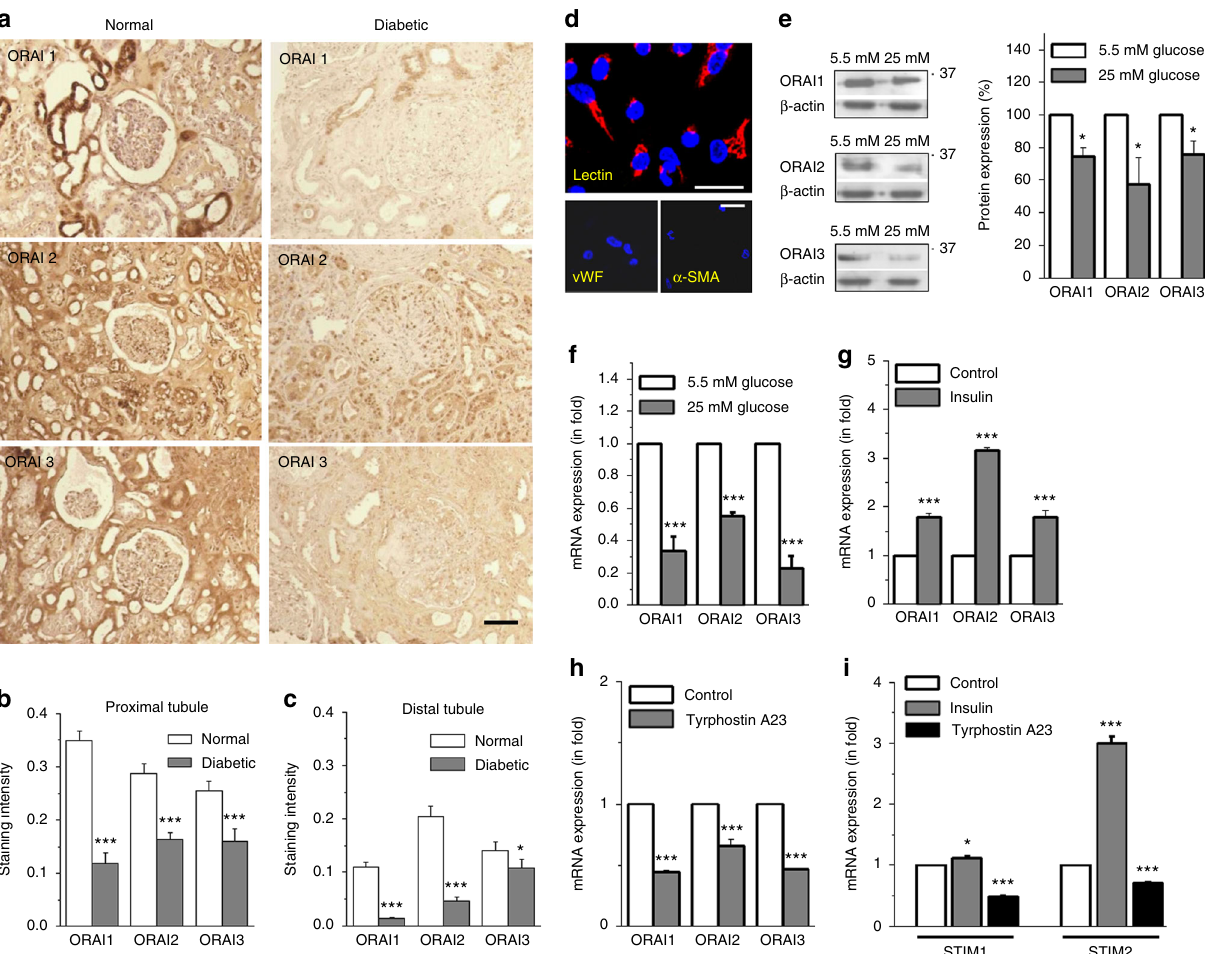
Fig. 1 ORAIs and STIMs in human kidney and regulation under diabetic condition. a Immunostaining for ORAIs in normal and diabetic kidney tissue sections. The diabetic kidney sections showing typical mesangial expansion and accumulation of mesangial matrix material. Scale bar, 100 µ m. b , c Mean ± s.e.m. for the staining intensity (arbitrary unit) in proximal tubules and distal tubules, respectively. The average of nine staining fi elds for each patient was calculated for proximal or distal tubule staining ( n = 6 for normal kidney, n = 8 for diabetic kidney). Also see staining for STIM1 and STIM2 (Supplementary Fig. 3). d Primary cultured human proximal tubular epithelial cells (PTECs) were characterized by lectin staining (red). Scale bars, 50 µ m. e PTECs were cultured with normal (5.5 mM) and high (25 mM) glucose for 60 h. ORAI proteins were detected by western blotting ( n = 6). f The mRNA of ORAIs was quanti fi ed by real-time PCR. The mean data were from 2 – 3 independent experiments ( n = 6). g The proximal tubular epithelial cells (HK-2) were treated with or without (control) insulin (10 nM) for 48 h and the mRNA was detected by real-time PCR ( n = 6). h HK-2 cells incubated with tyrosine kinase inhibitor tyrphostin A23 (30 µ M) for 48 h ( n = 6). i STIM1 and STIM2 expression after insulin (10 nM) and tyrphostin A23 (30 µ M) treatment for 48 h ( n = 9). The β -actin was used as control for relative quanti fi cation of mRNA or protein. For PCR experiments, triplicate reactions were set for each gene. The averaged data are displayed as mean ± s.e.m. and the data in e – i are normalized to control. The data sets are compared by t test. Statistical signi fi cance is indicated by * P < 0.05, *** P <